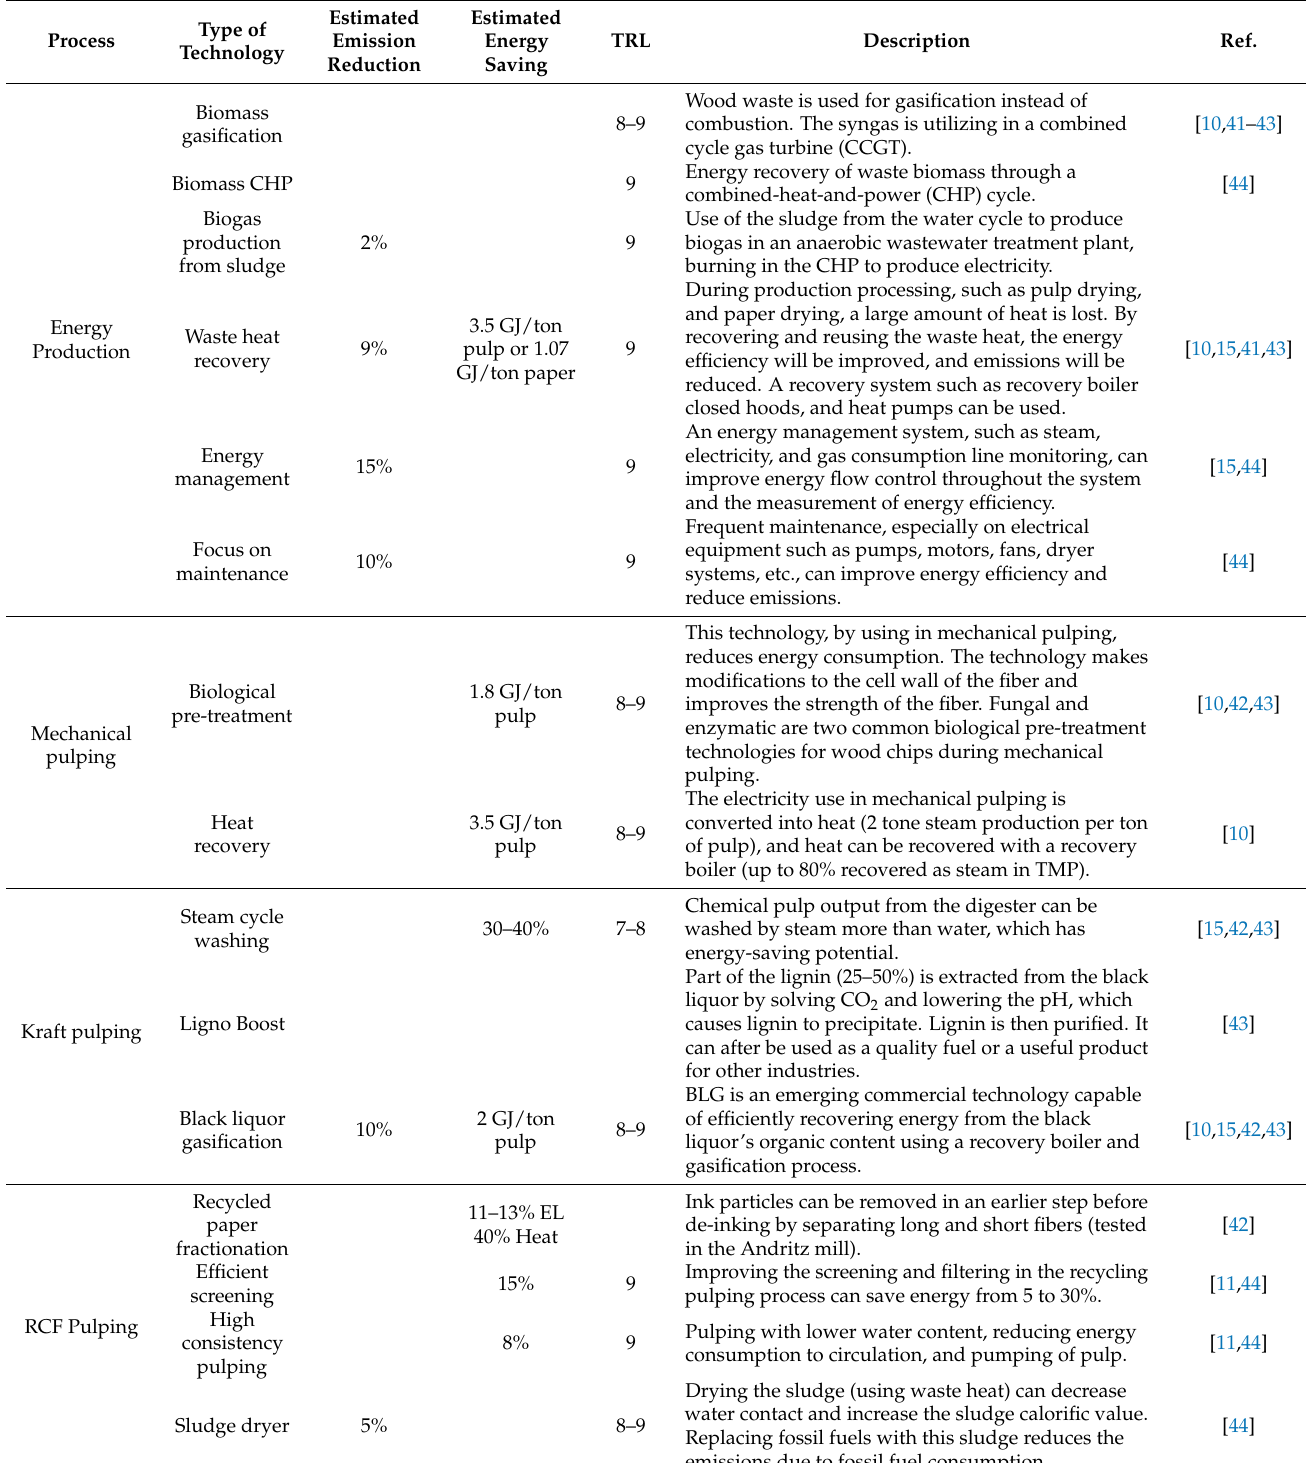
Table 8. An overview of the best available technologies (BAT) for the pulp and paper sector based on the literature review. Process